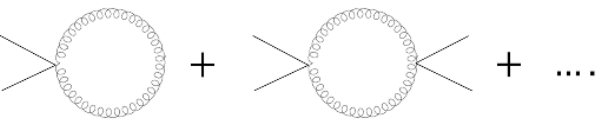
Figure 3 . The 1-loop diagrams we sum over for the 1-loop